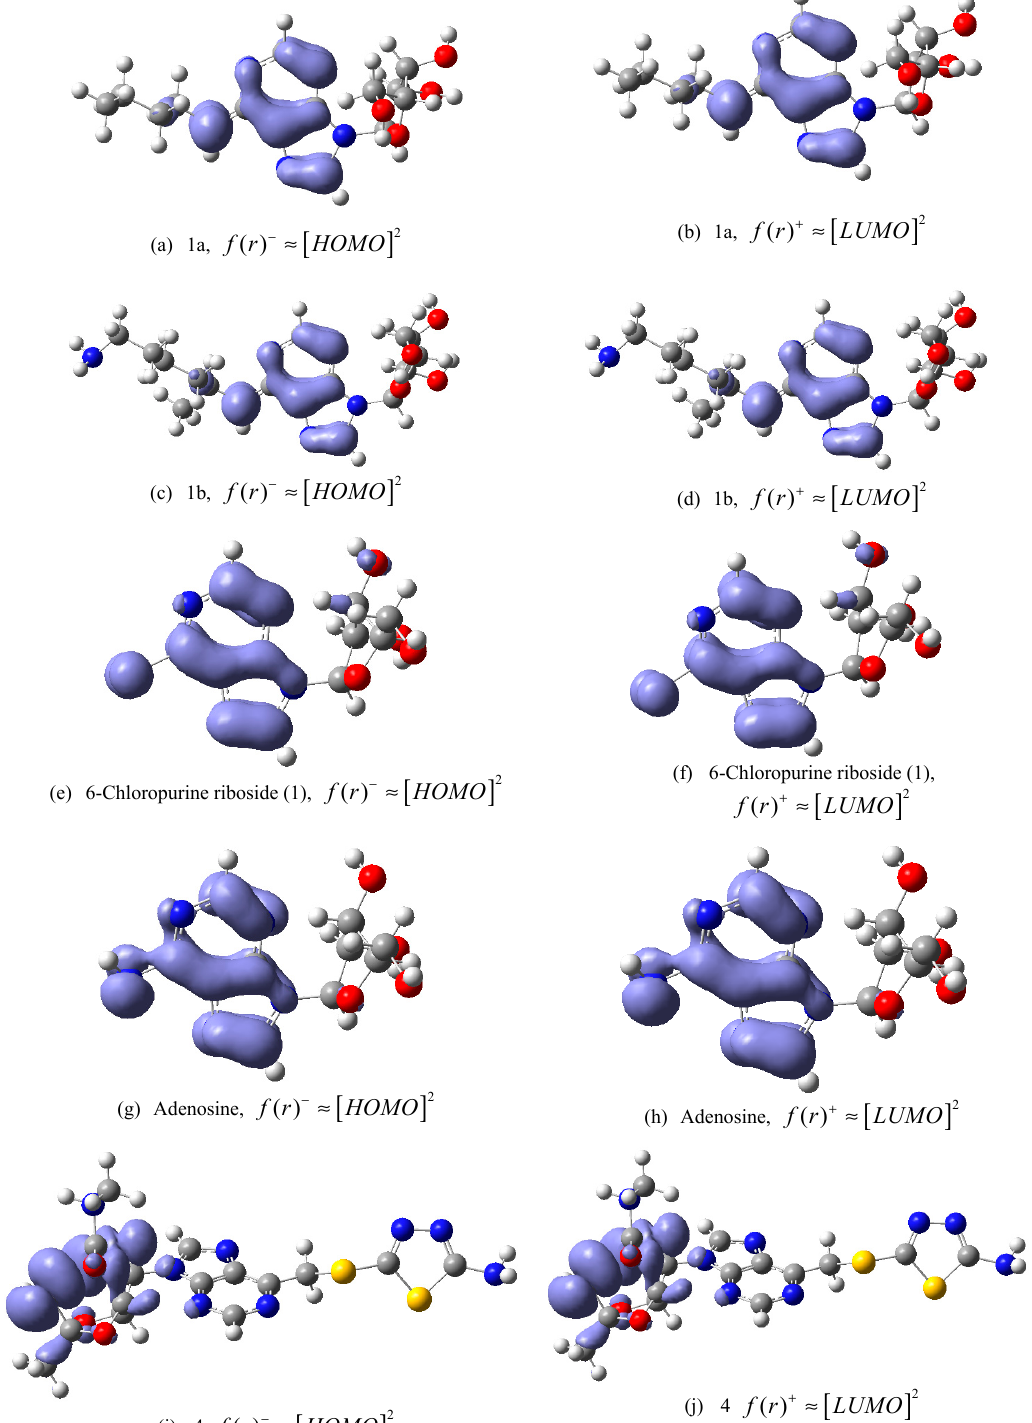
− ≈ [ [ ] 2 HOMO ] 2 and f ( r ) + ≈ [ LUMO ] 2 for ( ) f r HOMO − ≈ and